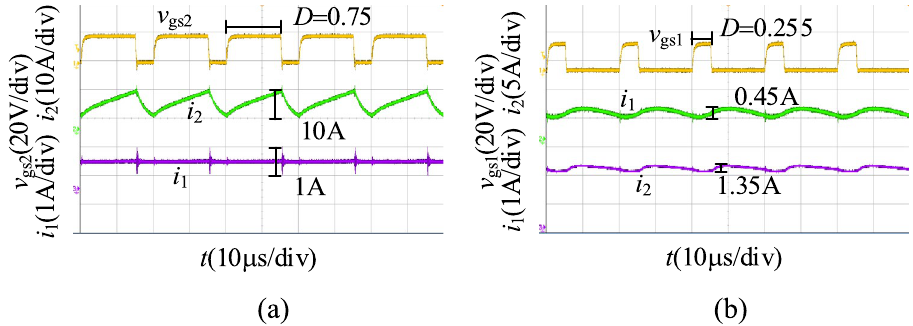
Figure 25. The input and output current waveforms of the proposed converter, ( a ) step-up mode, ( b ) step- down mode.